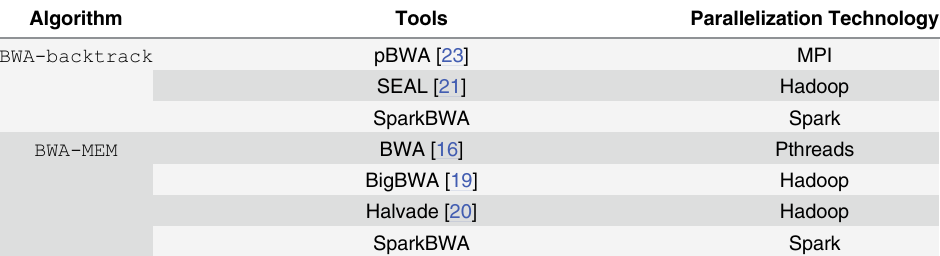
Table 3. Algorithms and BWA-based aligners evaluated.